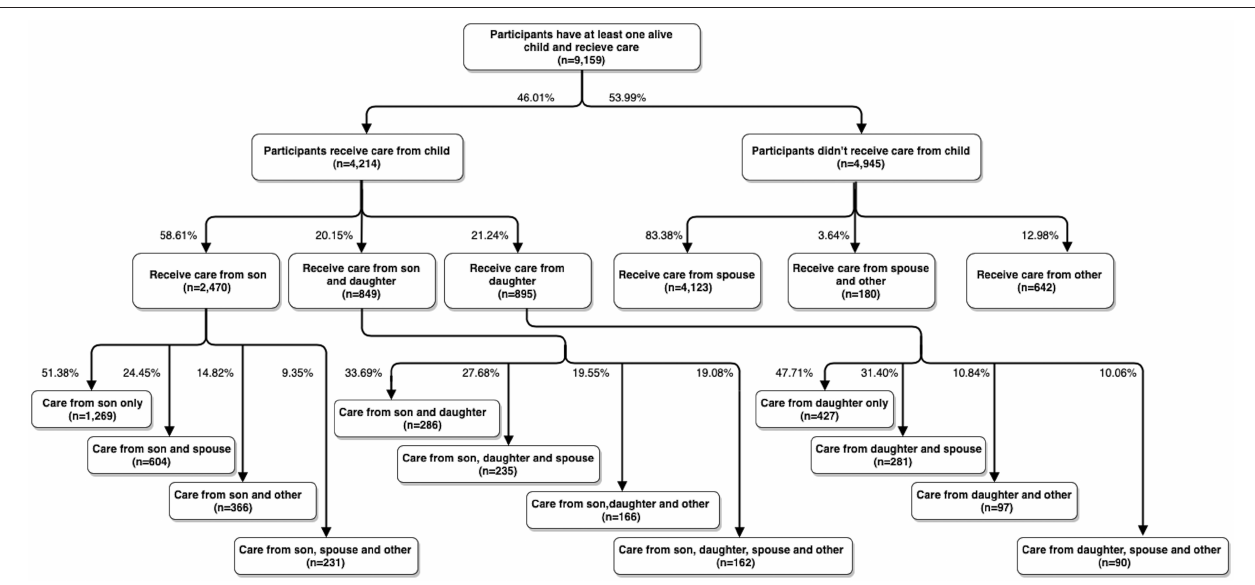
FIGURE 1 | Care structure for people aged 45 and over in